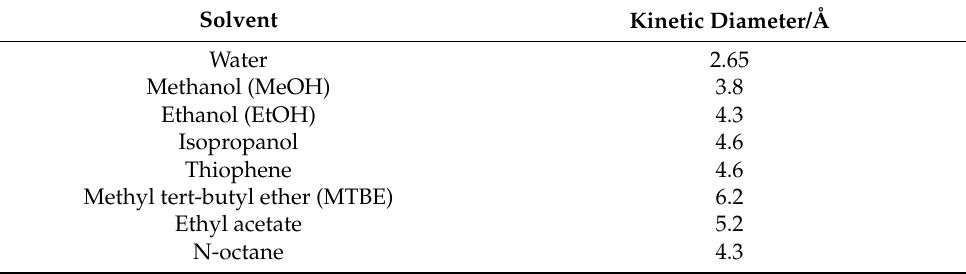
Figure 8. Separation performance of continuous MOF membranes in pervaporation: ( a ) H 2 O/EtOH separation, ( b ) H 2 O/Isopropanol, ( c ) EtOH/H 2 O, ( d ) MeOH/MTBE and ( e ) Thiophene/n − octane or n − butane. Reprinted with permission from Ref. [6]. Table 5. Physical parameters of liquid solvents in